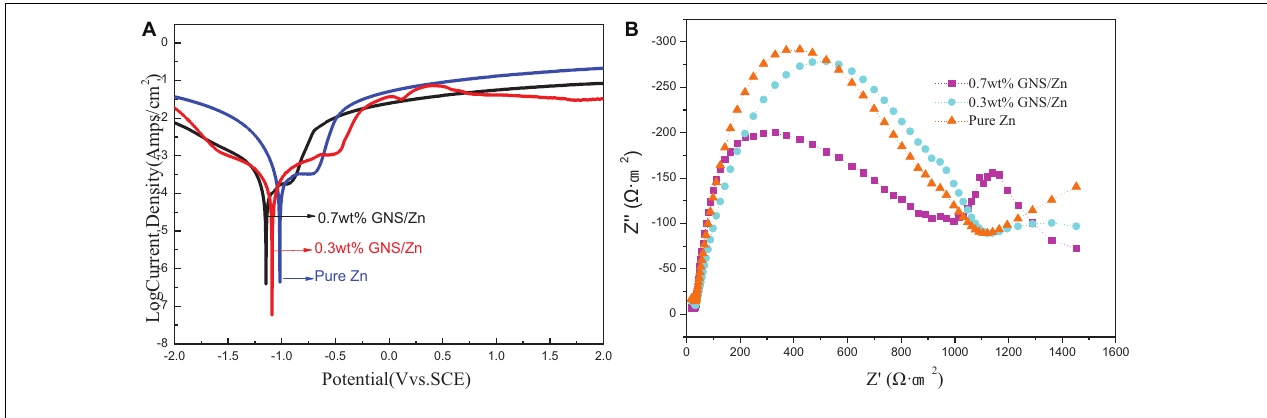
FIGURE 9 | Pure zinc and GNS/Zn composites: (A) polarization curve, (B) impedance spectrum.